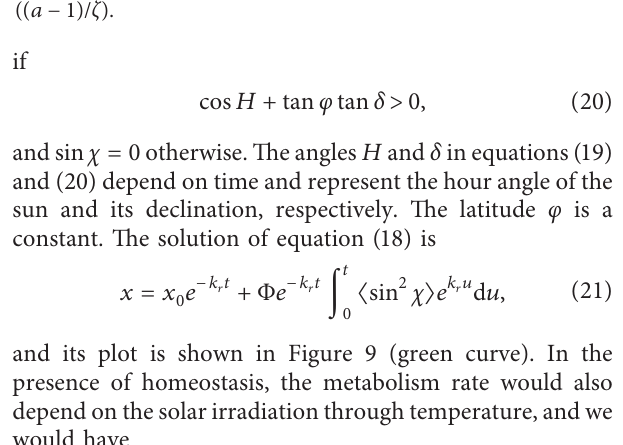
Q ( a, ζ ) versus aT